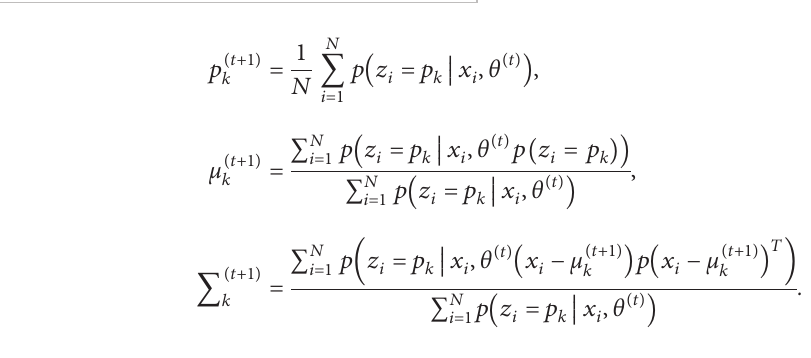
p � 1, and the point cloud data are sets of in- with 􏽐 K k k � 1 dependent and identically distributed (iid) points.